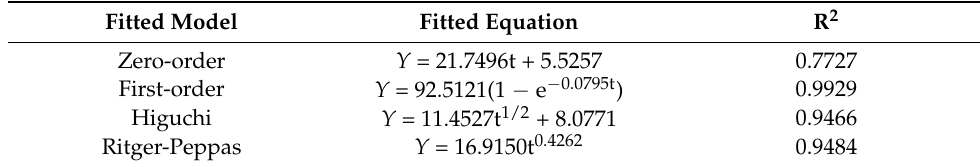
Table 4. Different release models of